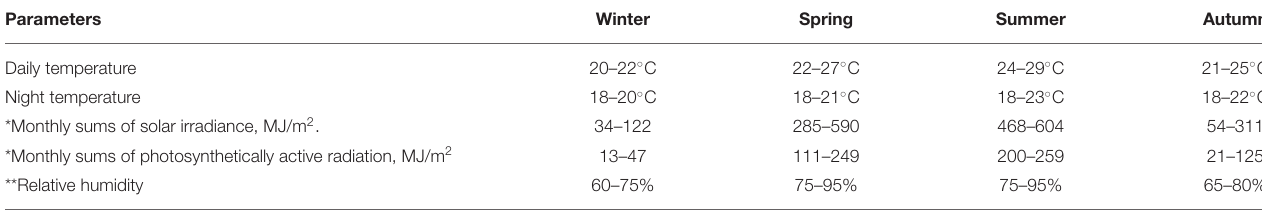
TABLE 1 | Microclimatic parameters of the tropical greenhouse Tzitzin Main Botanical Garden where the experiments were conducted. Parameters